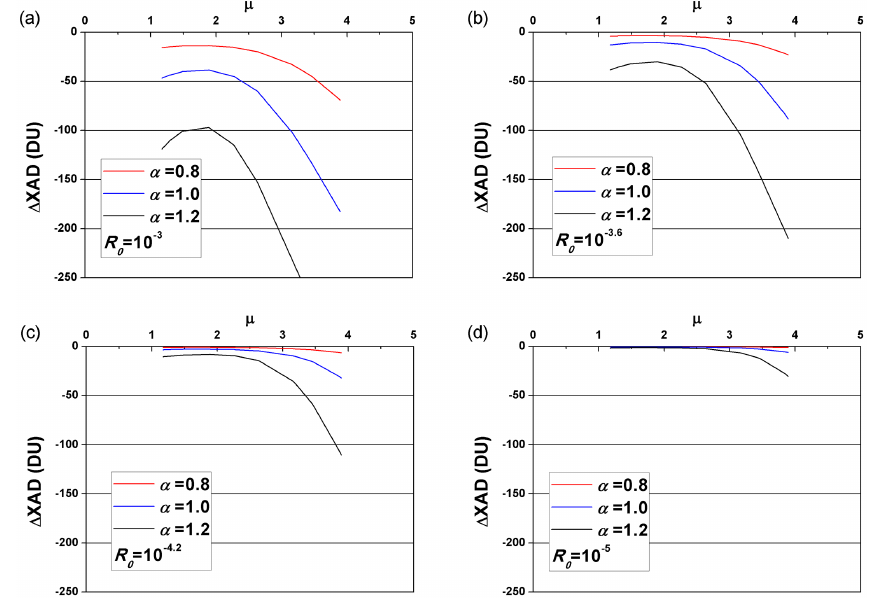
Figure 2. Variation of ozone error (cid:49)X AD as a function of air mass µ , for various values of parameters R 0 and α of the Basher model and for air masses µ 1 = 1 . 0 and µ 2 = 2 . 5.